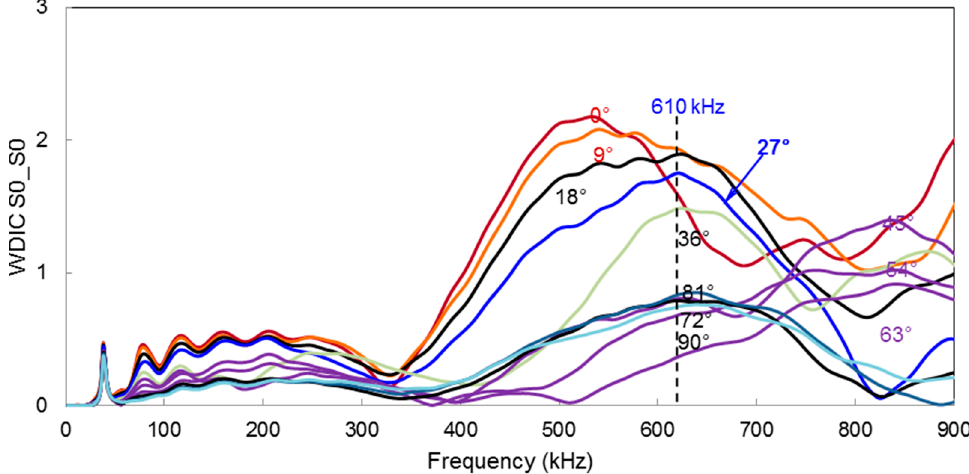
Figure 8. Frequency domain variation of WDIC S0_S0 for multiple incident directions.